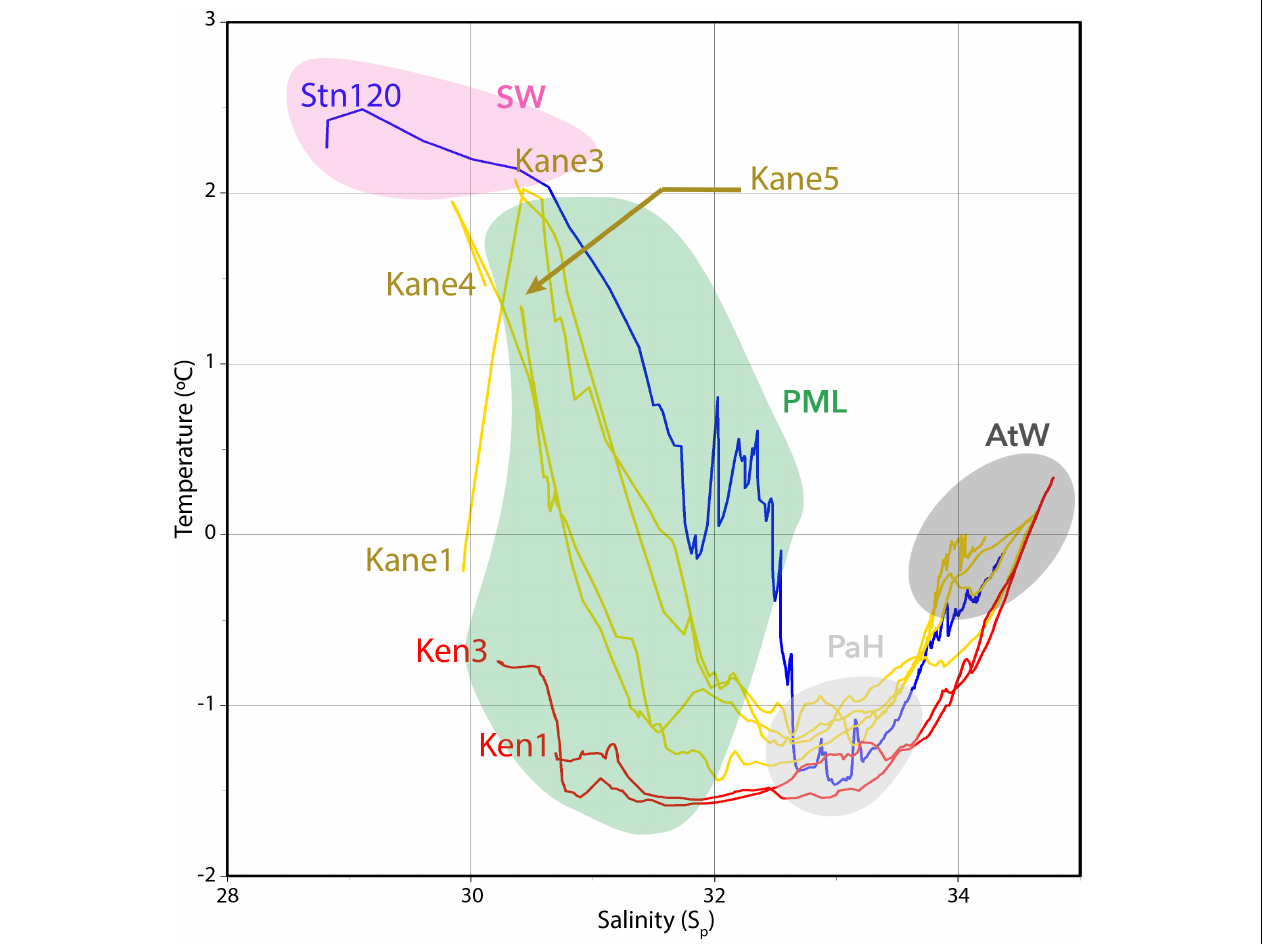
FIGURE 2 | Temperature versus salinity plots of the seven stations. Kennedy Channel stations (Ken) and Kane Basin (Kane) 1 in red; Kane Basin stations 3, 4, and 5 in yellow; and Station 120 in dark blue. The water masses identified in the text are indicated by shading with the polar mixed layer (PML) in green, Pacific Halocline (PaH) in light gray, and deep Atlantic water (AtW) in dark gray. The warmer surface waters (SW) are indicated in